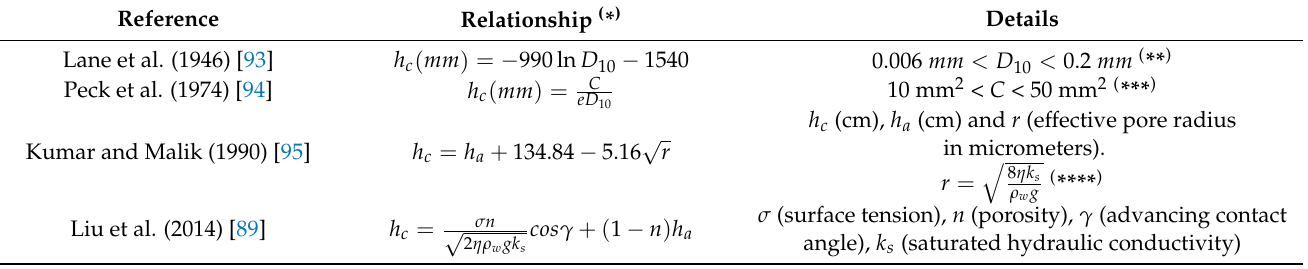
Table 1. Empirical relationships in literature for maximum capillary rise height estimations.